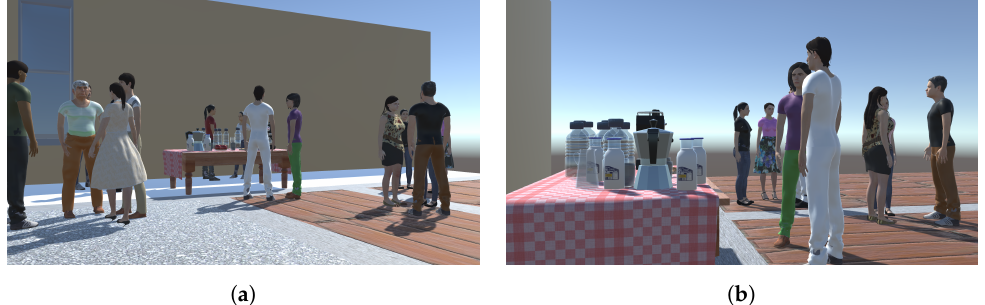
Figure 12. Images ( a ) and ( b ) are sample images of Scene 1 through robot’s camera from two positions (best viewed in